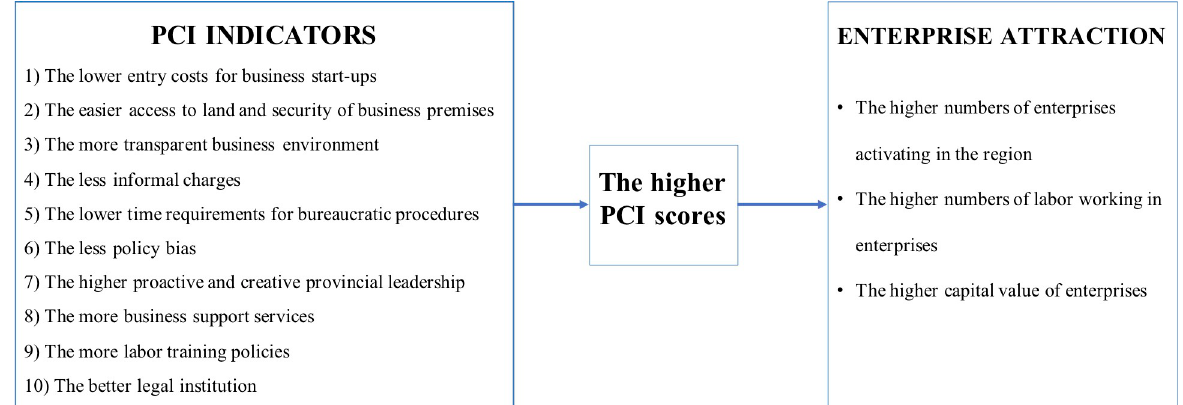
Fig 1. The hypotheses of